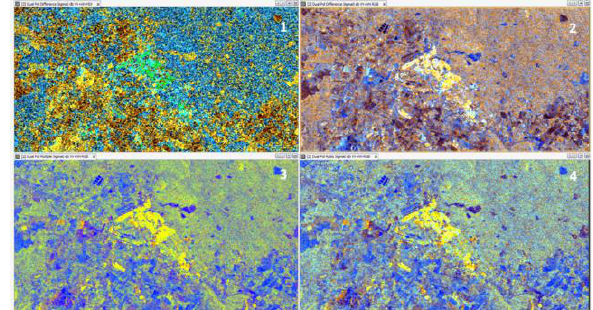
Figure 7. Color composition for several combination of polarization modes (VV, VH) that shows identification of wetlands and soil moisture separately.